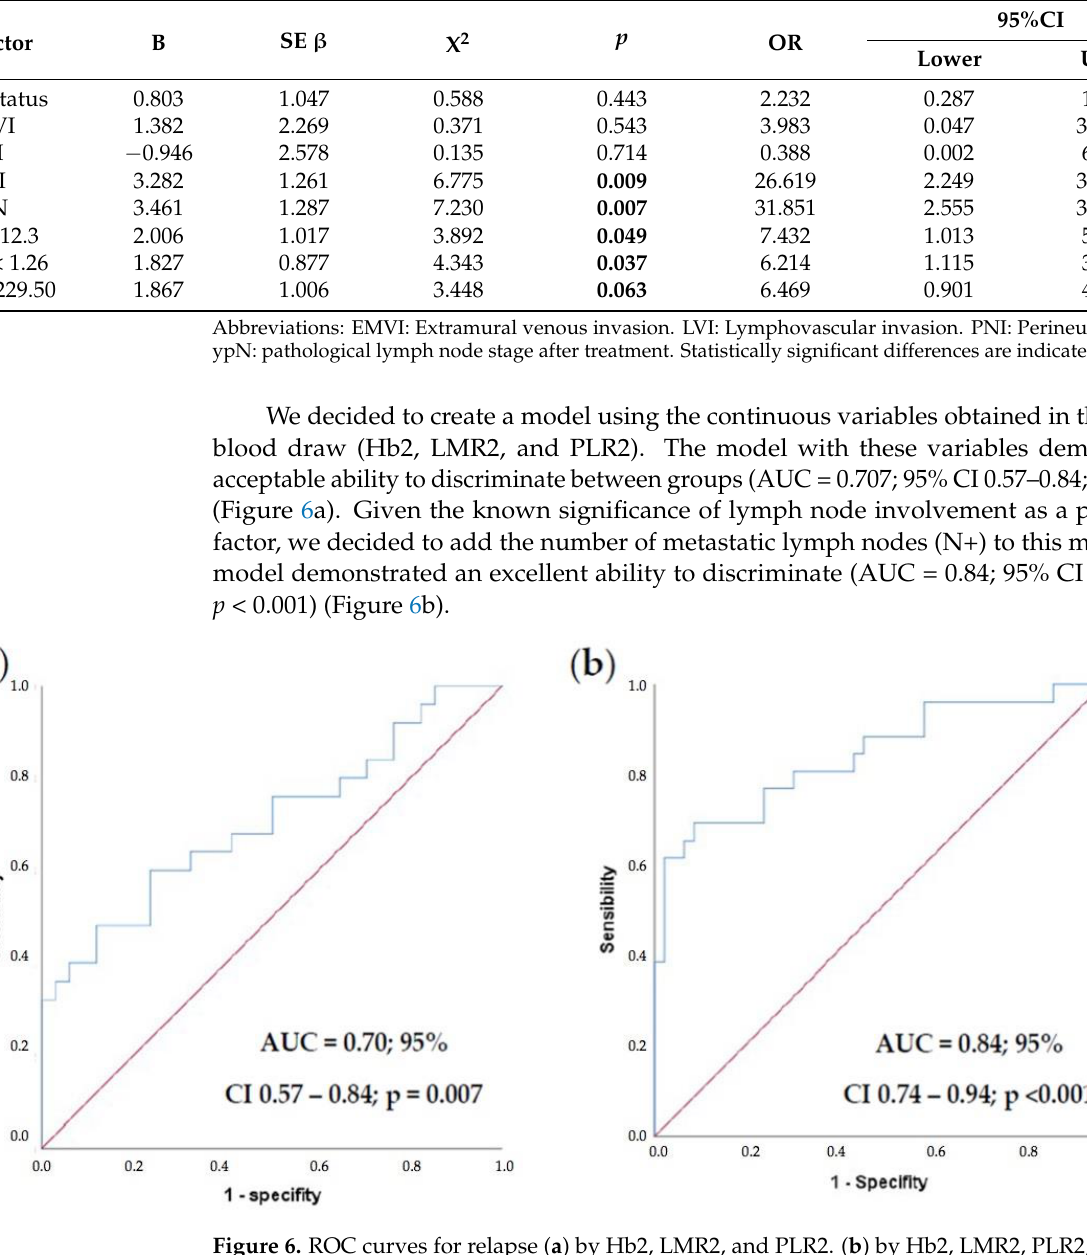
Figure 6. ROC curves for relapse ( a ) by Hb2, LMR2, and PLR2. ( b ) by Hb2, LMR2, PLR2, and